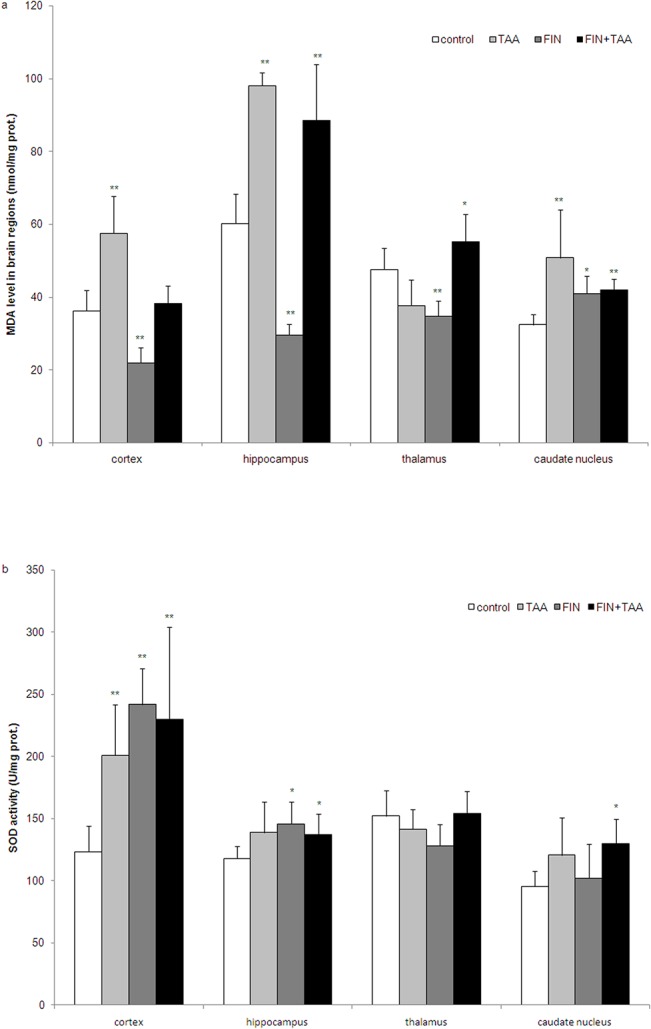
The effects of finasteride (FIN) and thioacetamide (TAA) on (a) malondialdehyde (MDA) level and (b) superoxide dismutase (SOD) activity in various brain regions.Four brain regions (dorsolateral frontal cortex, hippocampus, thalamus and caudate nucleus) were isolated 24 h after administration of the last dose of TAA and crude synaptosomal fractions were prepared for determination of parameters of oxidative stress. The significance of the difference was estimated by ANOVA with Fisher’s post hoc test (*p<0.05 and **p<0.01 vs. control in the same region). For details see caption for Fig 1.